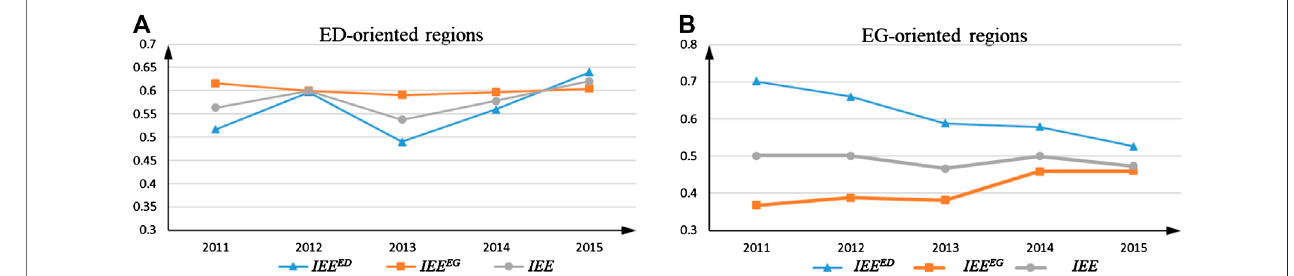
FIGURE 3 | The change of IEE, IEE ED and IEE EG in different